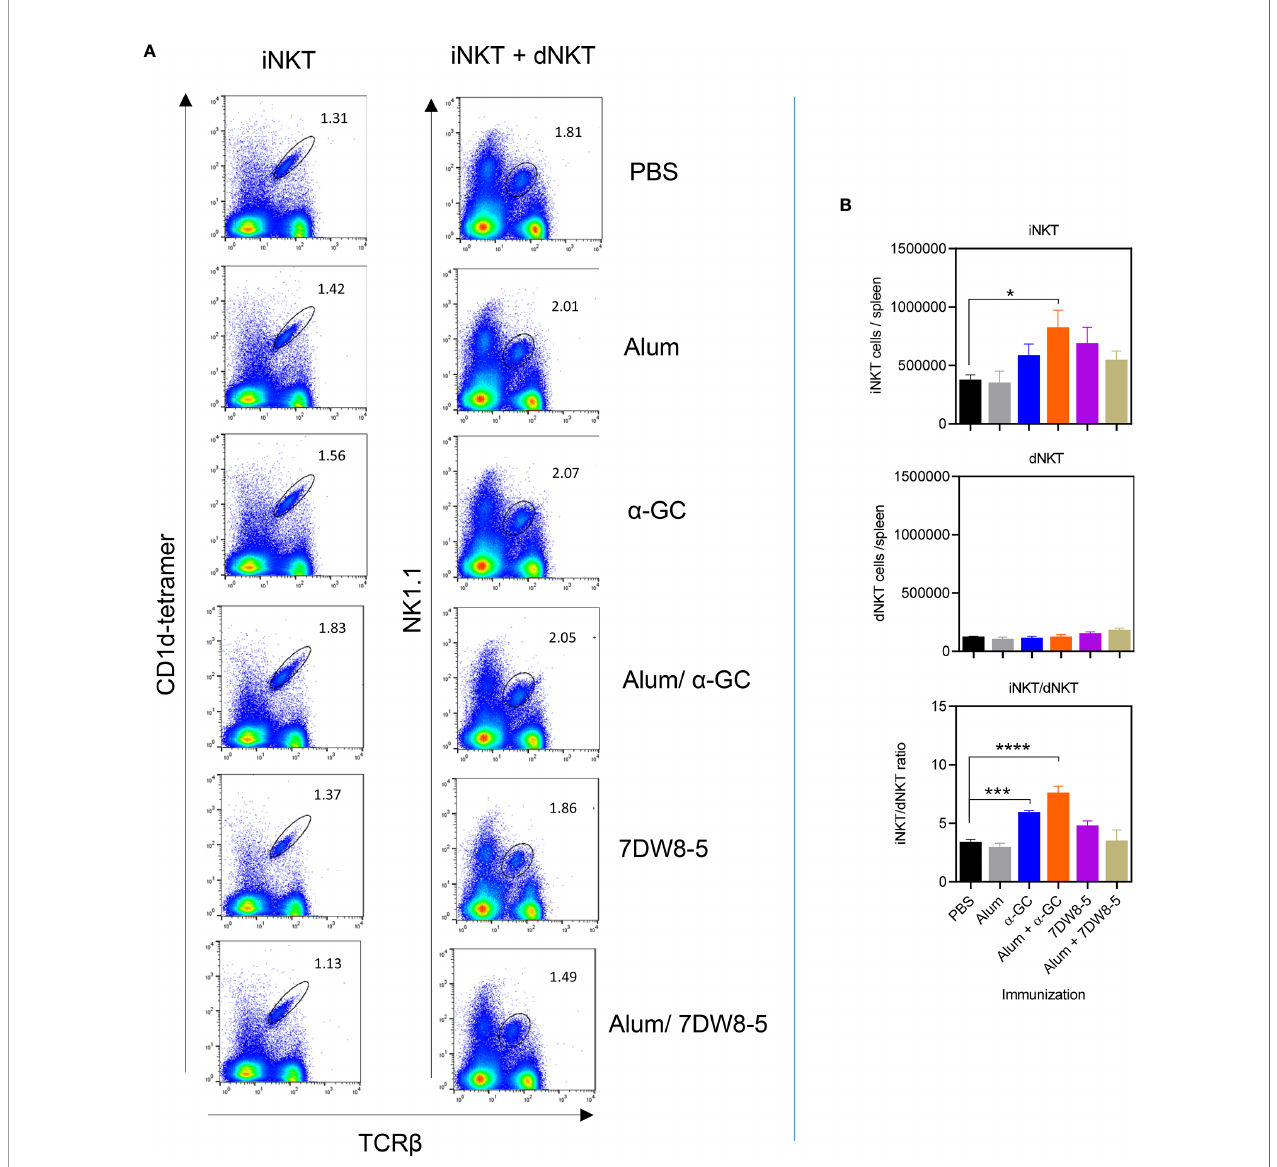
FIGURE 3 | The Alum/ a -GC combination adjuvant increases iNKT cell numbers and the iNKT/dNKT ratio. Mice were immunized as indicated and after 8 days, splenocytes prepared and examined by fl ow cytometry. (A) Shows representative fl ow cytometry plots of total NKT cells (iNKT and dNKT, left column) and of iNKT cells (right column). (B) Shows mean ± SEM absolute numbers of iNKT cells (upper panel) and dNKT cells (middle panel). dNKT numbers are calculated by subtracting the TcR b + /tetramer + population from the TCR b + /NK1.1 + population. Also shown is the iNKT/dNKT ratio for absolute numbers (lower panel). Data show 3 pooled experiments with similar results (PBS, Alum n=12, a -GC, Alum/ a -GC n=11, 7DW8-5, Alum/7DW8-5 n=3). One way ANOVA with Dunnett ’ s post-test was used to detect signi fi cant differences (*P < 0.05; ***P < 0.001; ****P <